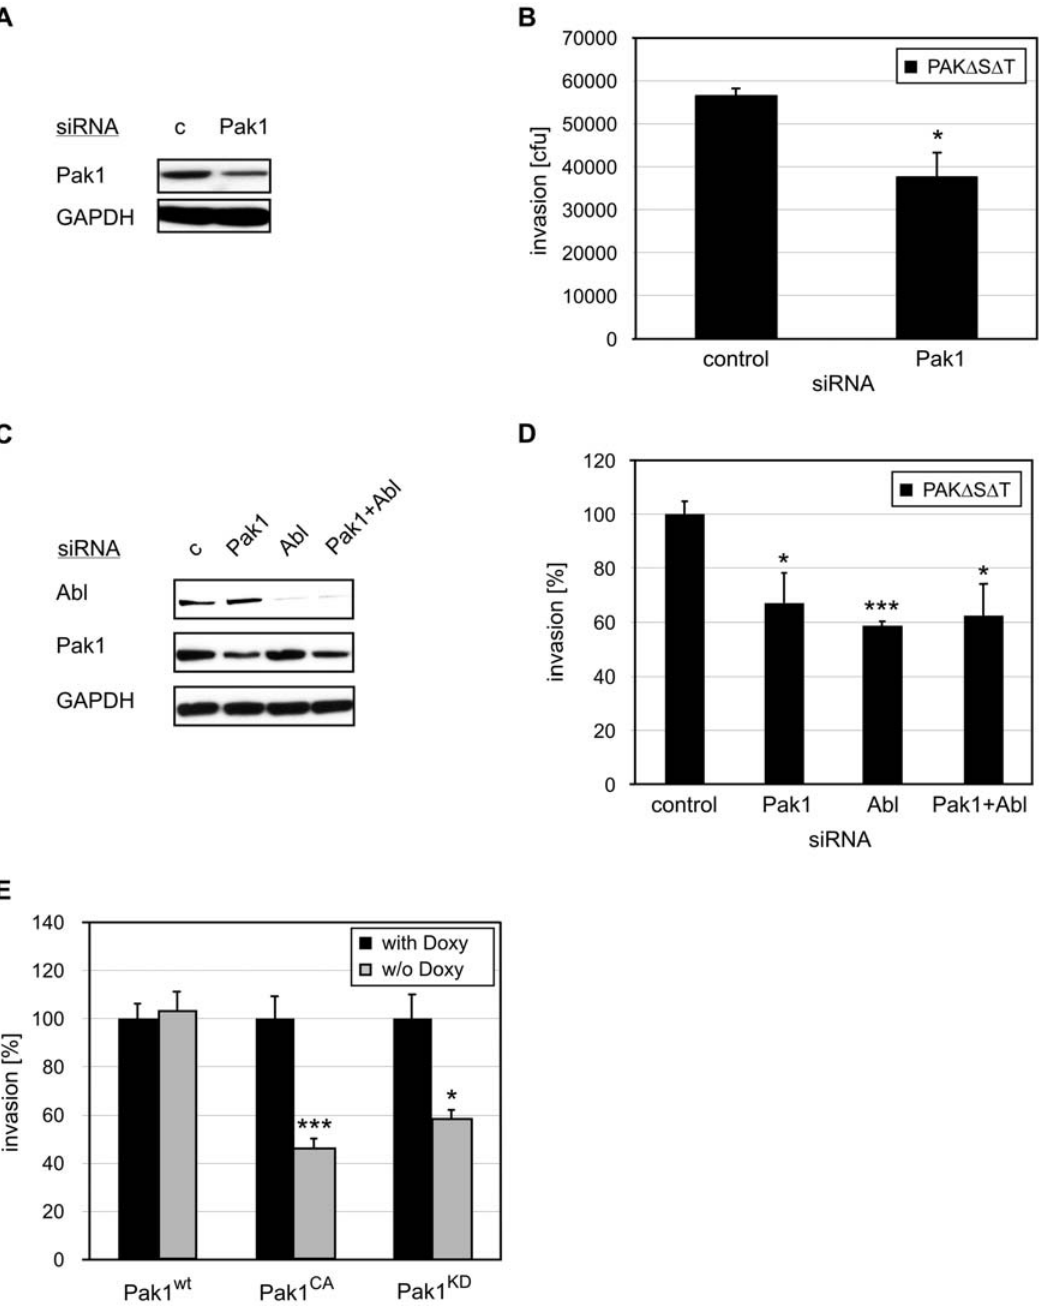
Figure 6. Invasion of P. aeruginosa is Pak1 dependent. (A) HeLa cells were treated with Pak1 or control (c) siRNA. Cell lysates were immunoblotted with anti-Pak1. GAPDH was used as loading control. (B) Internalization of PAK D S D T at 1 h was quantified in HeLa cells treated with control siRNA or siRNA against Pak1. *p , 0.05 compared to control siRNA-treated cells. (C) HeLa cells were treated with Pak1 and/or Abl siRNA or control siRNA. Cell lysates immunoblotted with anti-Pak1 and anti-Abl. GAPDH was used as loading control. (D) Internalization of PAK D S D T at 1 h was quantified in HeLa cells treated with control siRNA or siRNA against Pak1, Abl, and Pak1 + Abl. Results are normalized to control siRNA-treated HeLa cells. *p , 0.05, ***p , 0.001 compared to control siRNA-treated cells. (E) MDCK cells were induced for 18 h to express human Pak1 (Pak1 wt ), a dominant-negative (Pak1 DN ) or a constitutively active (Pak1 CA ) mutant of Pak1 by removal of doxycycline. Invasion of PAK D S D T at 1 h was quantified and the results were normalized with respect to uninduced cells. *p , 0.05, ***p , 0.001 compared to uninduced cells. Our work further demonstrates a role for Pak1 in P. aeruginosa Interestingly, expression of a constitutively active mutant as well as a kinase-dead mutant of Pak1 inhibited bacterial internalization invasion. Pak1 belongs to a family of highly conserved serine/ threonine kinases that are implicated in cytoskeletal rearrangements (Figure 6E). These findings corroborate that cycling of this kinase induced by GTP-bound forms of Rac1 and Cdc42 [58] (Figure 6). between an active and inactive state is required for its function [52].